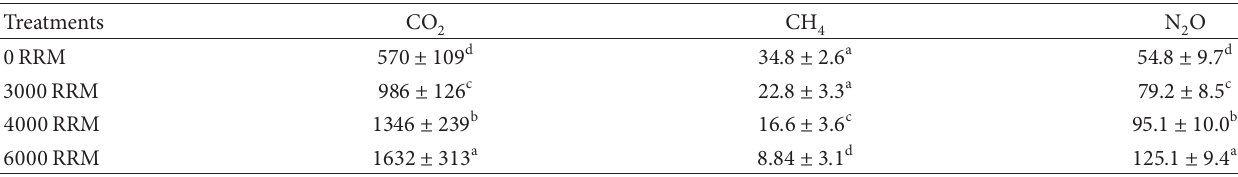
O (mg m − 2 ) from NT paddy fields under different residue mulching 2